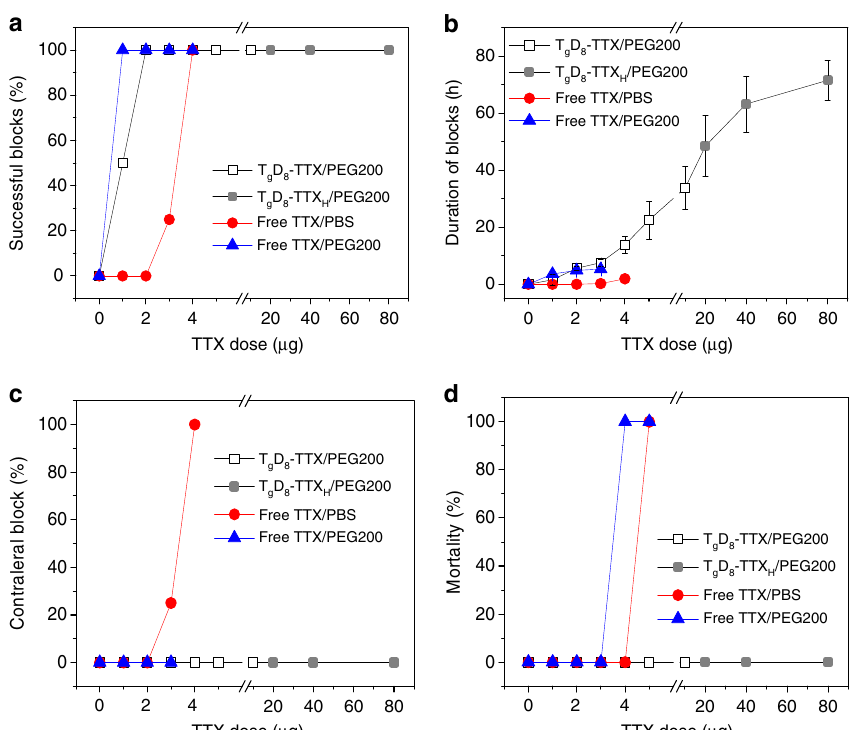
Fig. 3 Peripheral nerve blockade with free TTX and T g D 8 – TTX conjugate. Effects of TTX dose on a frequency of successful blocks, b duration of sensory nerve blocks, c frequency of nerve blocks in the uninjected (contralateral) extremity, and d animal mortality. In all panels, the open box denotes T g D 8 – TTX, the gray box denotes T g D 8 – TTX H . Data are means ± SD, n =